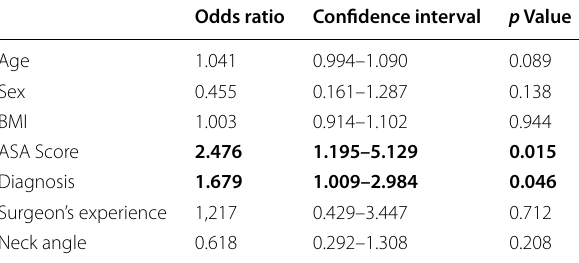
Table 4 Logistic regression for age, sex, BMI, ASA Score, diagnosis, surgeon’s experience, and neck angle; odds ratio, confidence interval (95%), and p